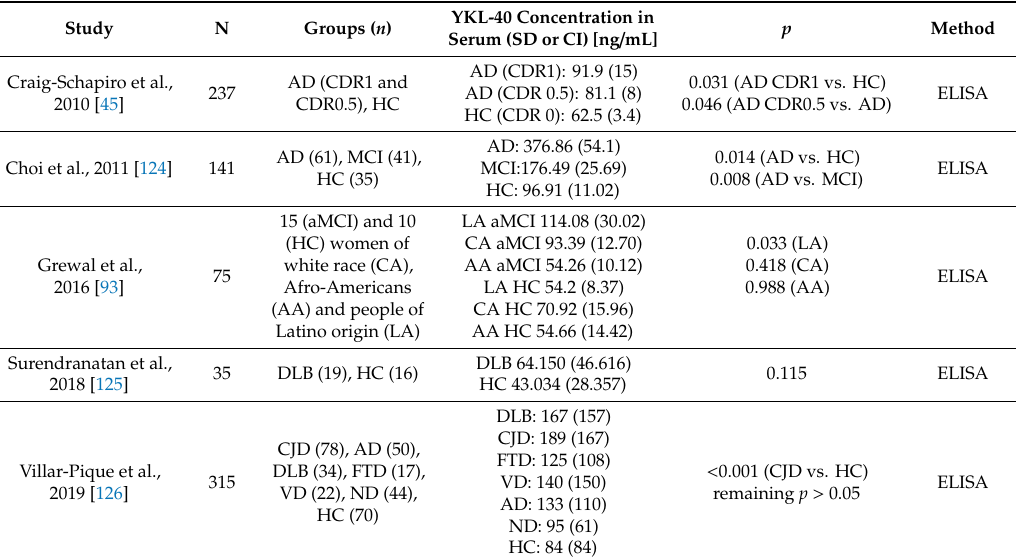
Table 5. YKL-40 concentration in serum